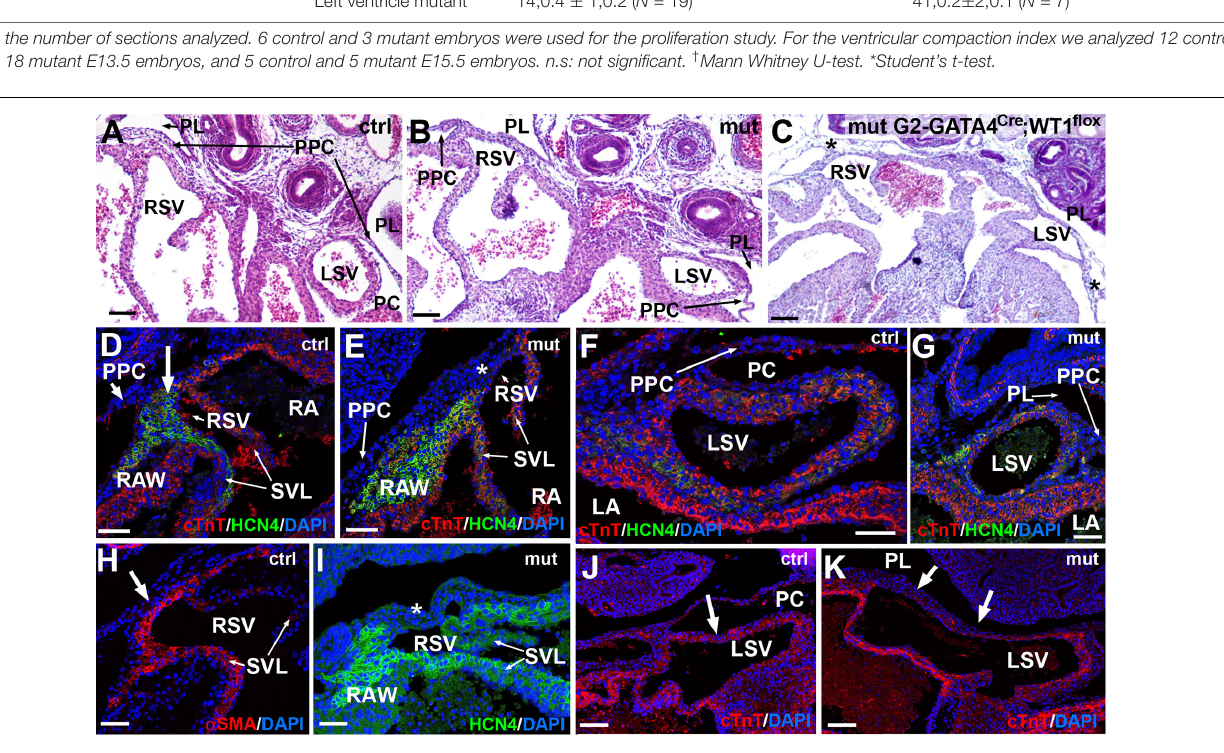
FIGURE 5 | Sinus venosus defects caused by the of the conditional WT1 loss of function in cardiomyocytes (Tnnt2 Cre / + ; WT1 flox / flox line). (A,B) Comparison of the right and left sinus venosus (RSV, LSV) in E13.5 control and mutant embryos, respectively. The sinus venosus in the control embryos show a posterior wall covered by the epicardium, limited by the pericardial cavity (PC) and free from the pleuropericardial membranes (PPC). The mutant embryos show posterior walls continuous with the pleuropericardial membranes and limited by the pleural cavities (PL). (C) G2-GATA4 Cre ;WT1 loxP model of conditional deletion of WT1 in lateral mesoderm. In this E13.5 mutant embryo the PPC are lacking, and the posterior wall of the right and left sinus venosus are embedded in the body walls (asterisks). (D–K) Immunocytochemical features of the posterior wall of the mutant sinus venosus (E,G,I,K) as compared with the control embryos (D,F,H,J) . Stage E15.5. The mutant walls show fewer cardiomyocytes and myocardial discontinuities (asterisk in E , arrows in K , compare with arrows in D,H,J ). Note the lack of HCN4 expression in the posterior wall of the mutant right sinus venosus (asterisks in E,I ). The expression of HCN4 is extended in these embryos toward the right atrial wall (RAW). Scales: 50 µ